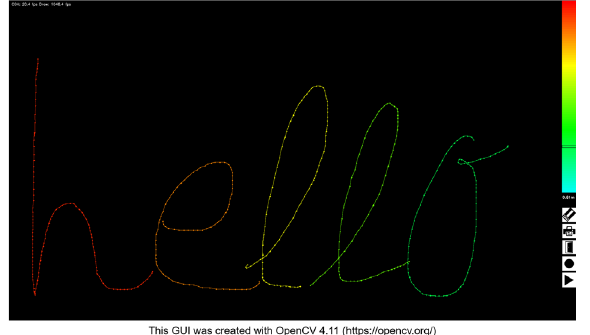
Figure 10. GUI display for this